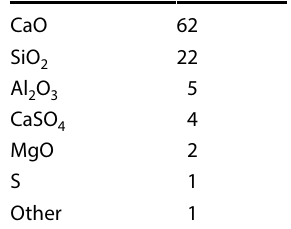
Chemical com- position